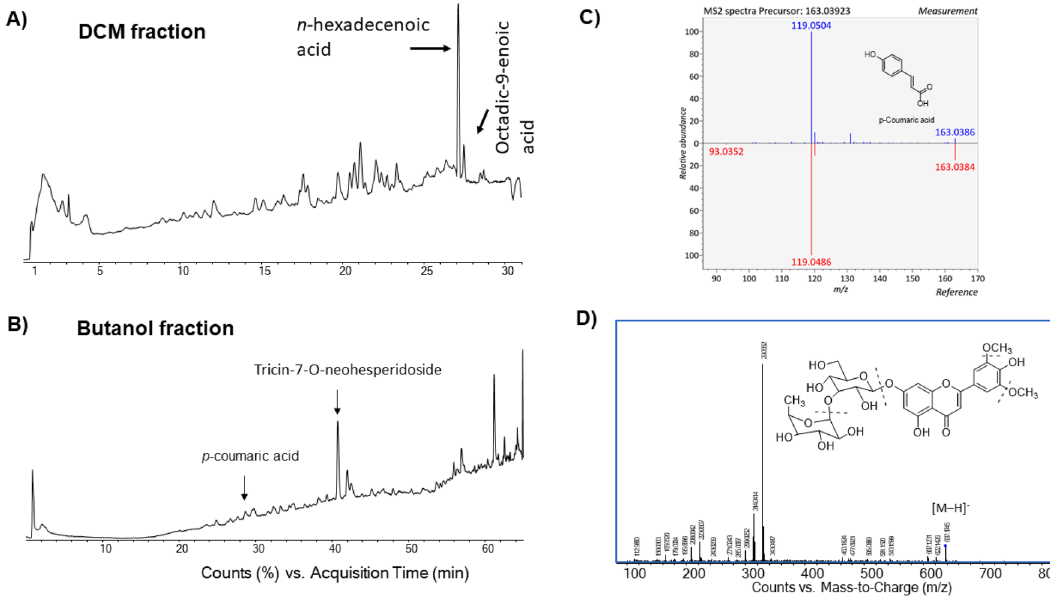
Figure 4. LC-TOF-(negative mode) MS/MS analysis of the DCM ( A ) and butanol ( B ) fractions of sugarcane leave extracts. ( C ) Exemplar tentative identification of p -coumaric acid (4-hydroxycinnamic acid) from the butanol fraction via MS-Dial tool. Comparison of CID MS/MS spectrum of p -coumaric acid (25 V) with that of reference spectrum in the library. ( D ) Tentative identification of tricin-7- O -eohesperoside from the butanol fraction via a combination of MS-Dial tool and local sugarcane compound database. CID-MS/MS spectrum (40 V) of mass 637.1784 indicating a major fragment ion at m/z 329.0676 through the loss of rhamnose and glucose. Initial loss of rhamnose (− 146) was also observed on the positive CID-MS/MS (15 V) spectrum (Supplementary Fig. S5) in agreement with data in literature 38 .